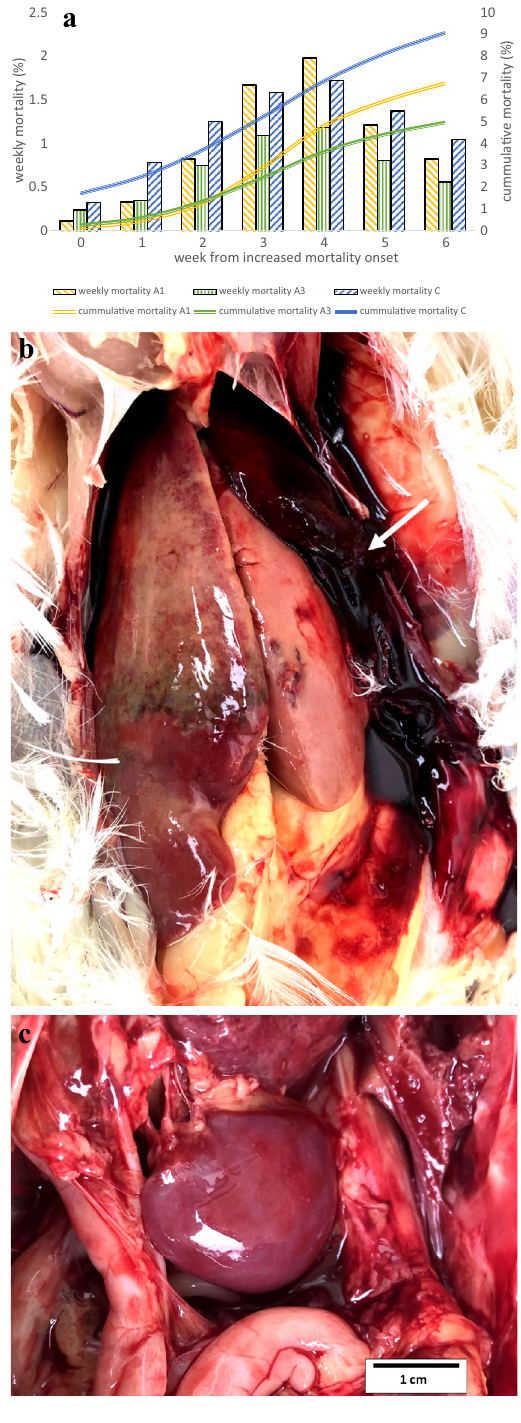
Figure 1. Characterization of aHEV field outbreaks in Poland. Weekly and cumulative mortality values (%) in three affected flocks—A1, A3, and C ( a ), and predominant post-mortem findings in the liver ( b ), where hemorrhagic hepatitis with hepatomegaly and clotted blood ( → ) can be observed, together with splenomegaly ( c